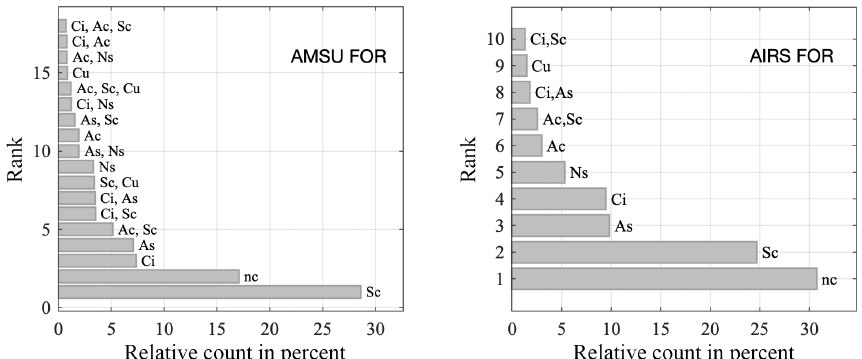
Figure 1. Histogram of cloud scenes containing relative counts of occurrence observed at the AMSU FOR and AIRS FOV resolution ( ∼ 45 and ∼ 15km respectively). The cumulative sum of the relative counts of these 18 (10) cloud scenes amounts to more than 90% of all cloud scenes observed globally over a period of 2 years at AMSU (AIRS) resolution.